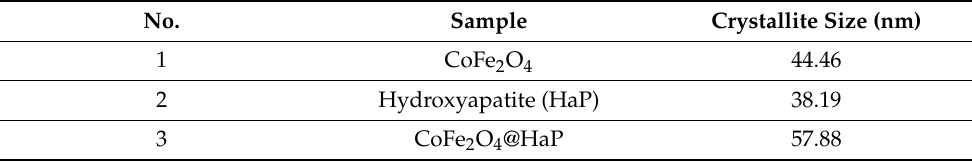
Table 1. The values of the crystallite size for the three samples.